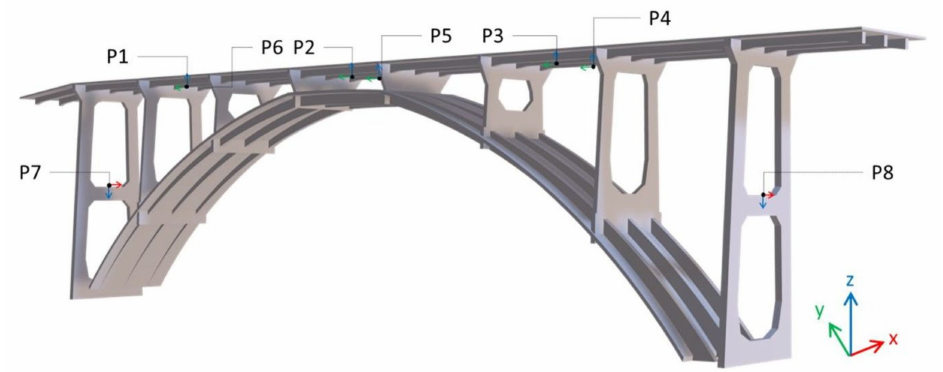
Figure 7. The layout of the accelerometers system installed on the bridge. Axes orientation is represented by the red arrow for x -direction, green for y -direction and blue for z